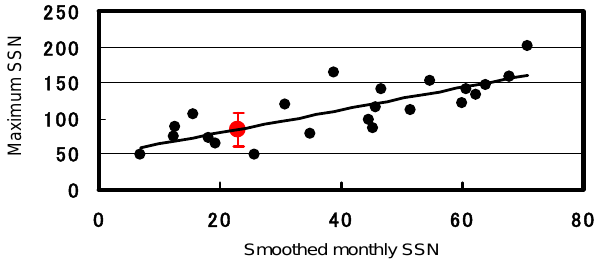
Fig. 7. Scatter plot of maximum sunspot number in the succeeding cycle versus monthly smoothed sunspot number three years before the minimum. The red circle shows the predicted maximum sunspot number for cycle 24 and the bar indicates 1-sigma